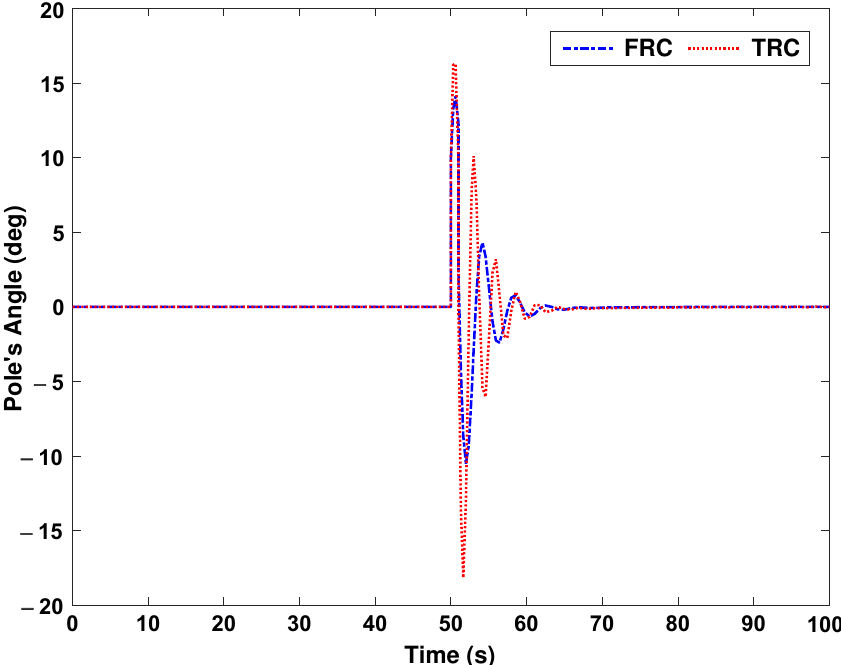
Figure 12. Angle control of inverted pendulum by FRC and